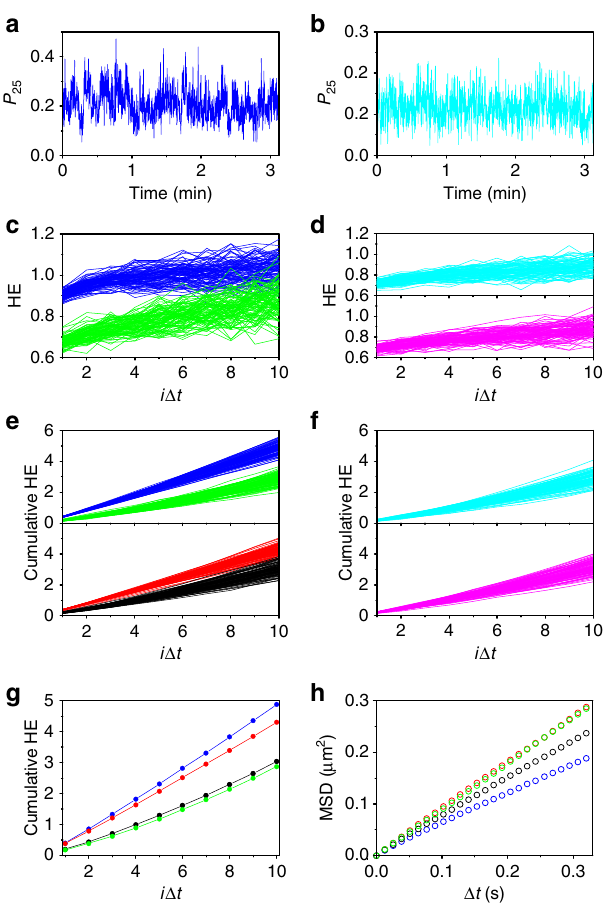
Figure 3 | Detrending fluctuation analyses of the time-dependent P 25 profile of ColE 1 DNA. ( a ) Time-dependent P 25 profile of the DNA molecules. ( b ) Time-dependent P 25 profile of the nanospheres. ( c ) Hurst exponent (HE)- i D t profiles of the experimental (blue) and the S r A r replicates (green) of the ColE 1 DNA. ( d ) HE- i D t profiles of the experimental (cyan) and the S r A r replicates (magenta) of the nanospheres. ( e ) Cumulative HE of the experimental (blue), the S r A r (green), the S i A r (red) and the S r A i (black) replicates of the ColE 1 DNA. ( f ) Cumulative HE of the experimental (cyan) and the S r A r replicates (magenta) of the nanospheres. ( g ) Averaged cumulative HE of the experimental and simulated replicates shown in e . The same colour coding as in e is used. ( h ) MSD- D t profiles of the experimental and the simulated replicates. The same colour coding as in e is used. green line) and the S i A r (Fig. 3h red line) replicates produced